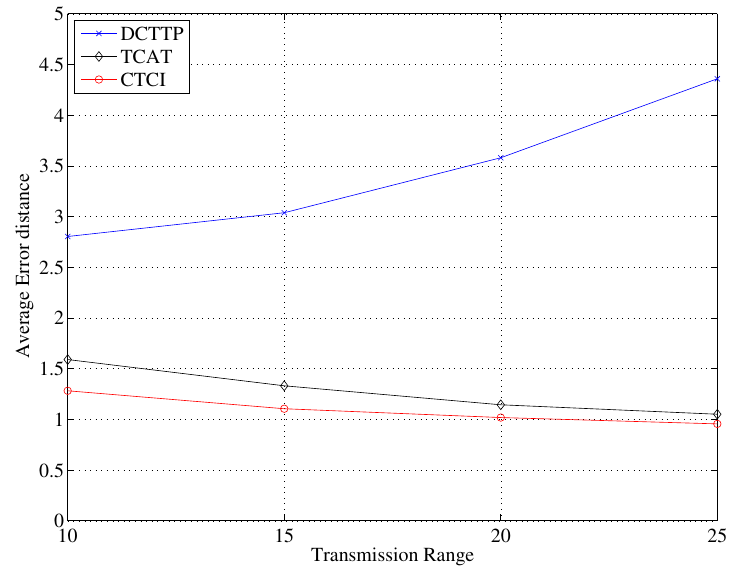
Figure 17. Impact of transmission range on the average error distance.